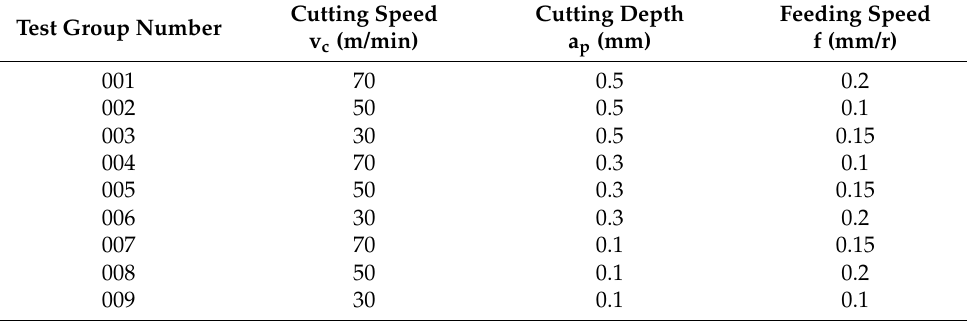
Table 4. Experimental layout using an L9 orthogonal